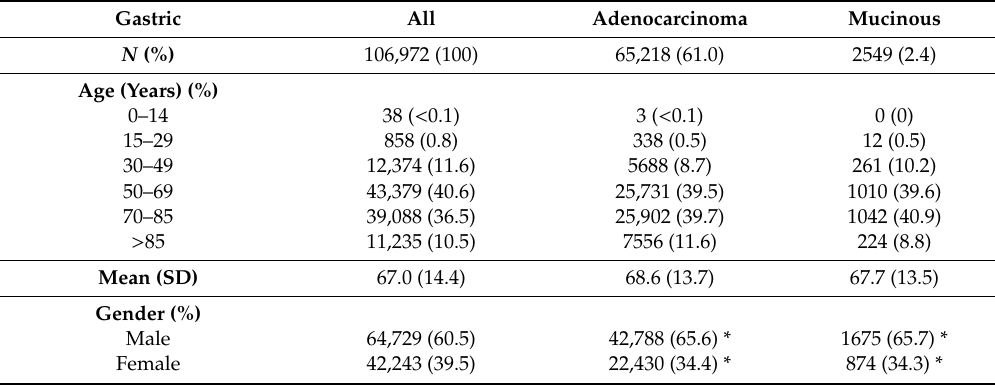
Table 11. Baseline demographics and clinical characteristics by histology for gastric